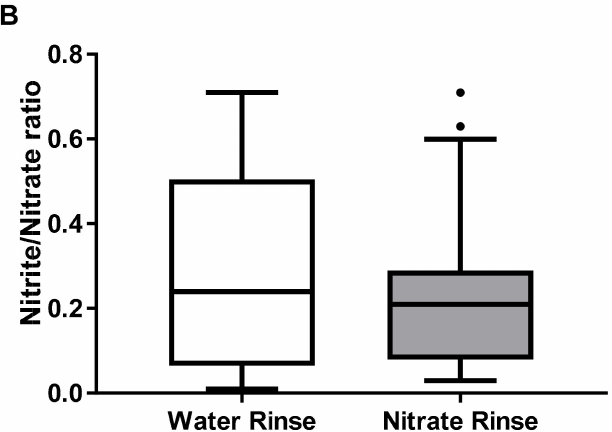
Figure 1. Oral nitrate-reducing capability. ( A ) Nitrate and nitrite concentrations in a mouth rinse